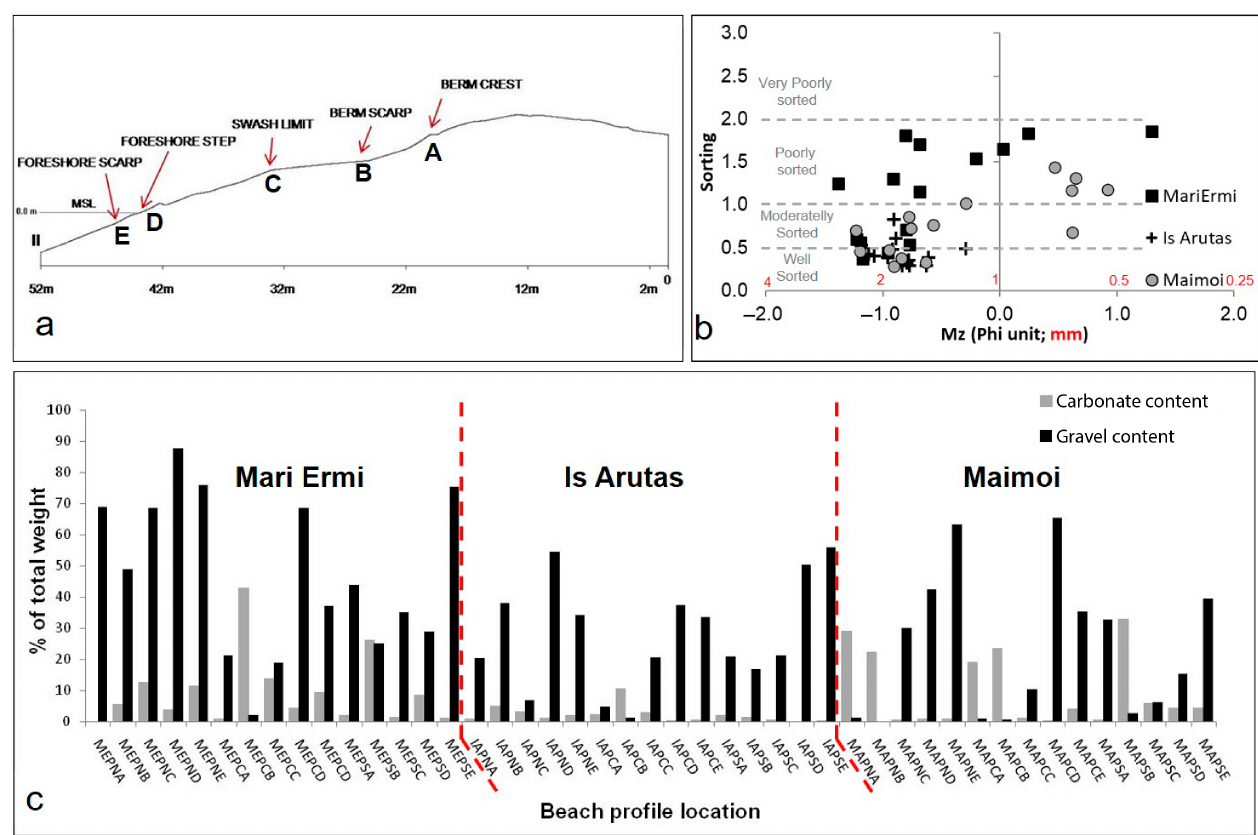
Figure 3. ( a ) The scheme of the sampling design along a beach profile; ( b ) a scatterplot of the mean grain size vs sorting of the collected sediment; ( c ) the content of siliciclastic gravel and carbonate in the sediment collected on each beach. The labeling of each sample is characterized by the name of the beach (two letters MEMari Ermi, IA—Is Arutas, MA—Maimoi); the location of profile (N—northern, C—central, S—southern).